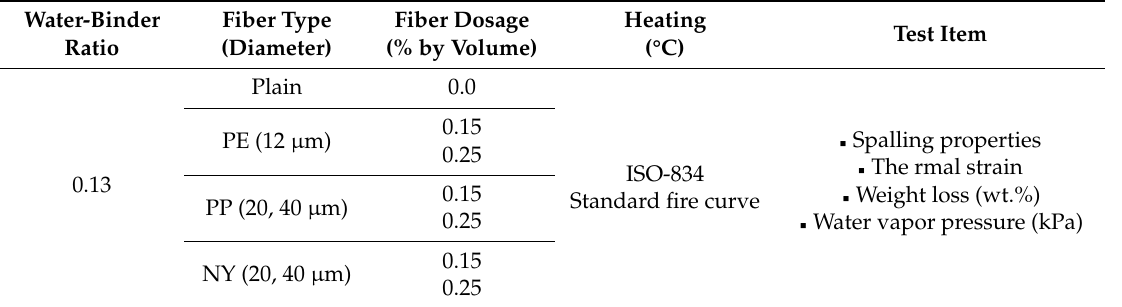
Table 4. Mixture proportions and properties of fresh and hardened concretes. Concrete